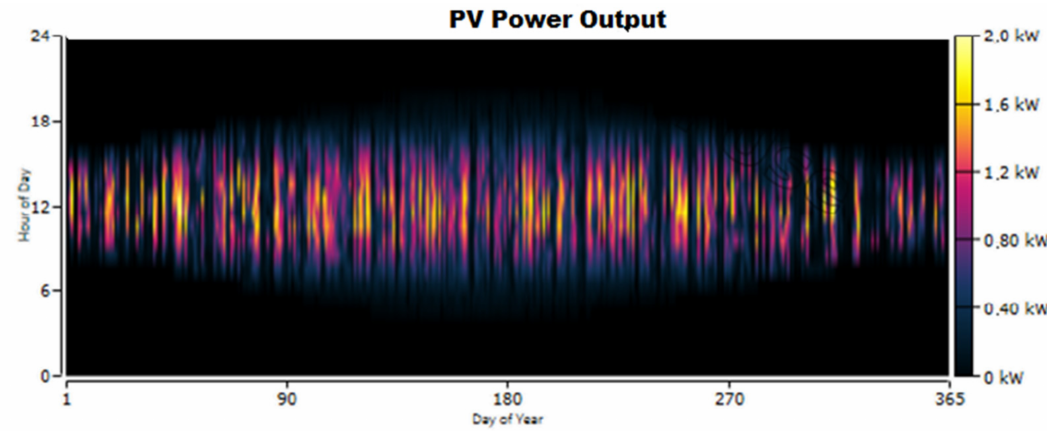
Figure 7. PV Power Output for the Lubuskie Voivodeship. Source: own study using Homer Grid